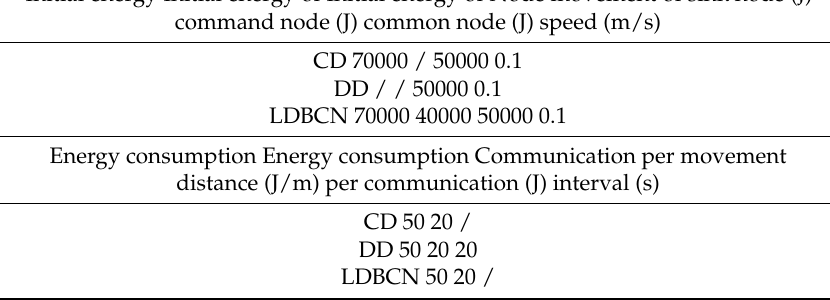
Table 1. Parameter settings of three dispatch algorithms.